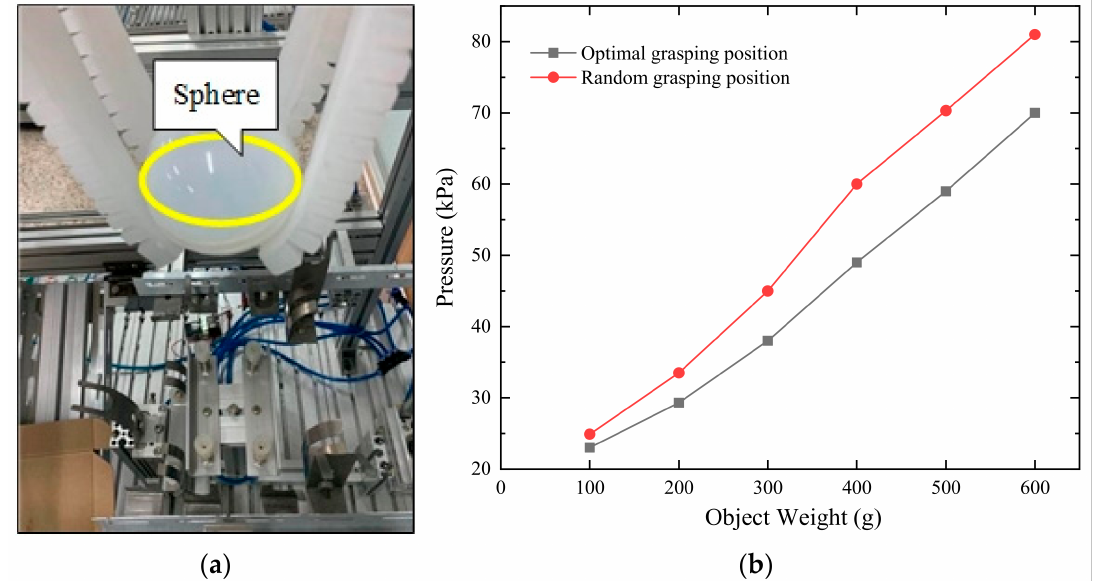
Figure 15. ( a ) Test to grasp a sphere; ( b ) comparison of experimental results of optimal grasping